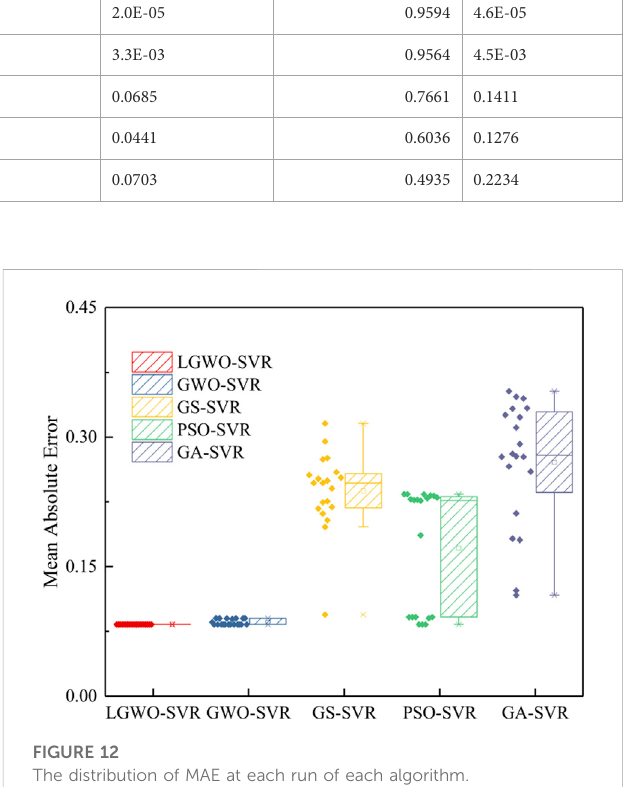
FIGURE 10 The distribution of RMSE at each run of each algorithm.